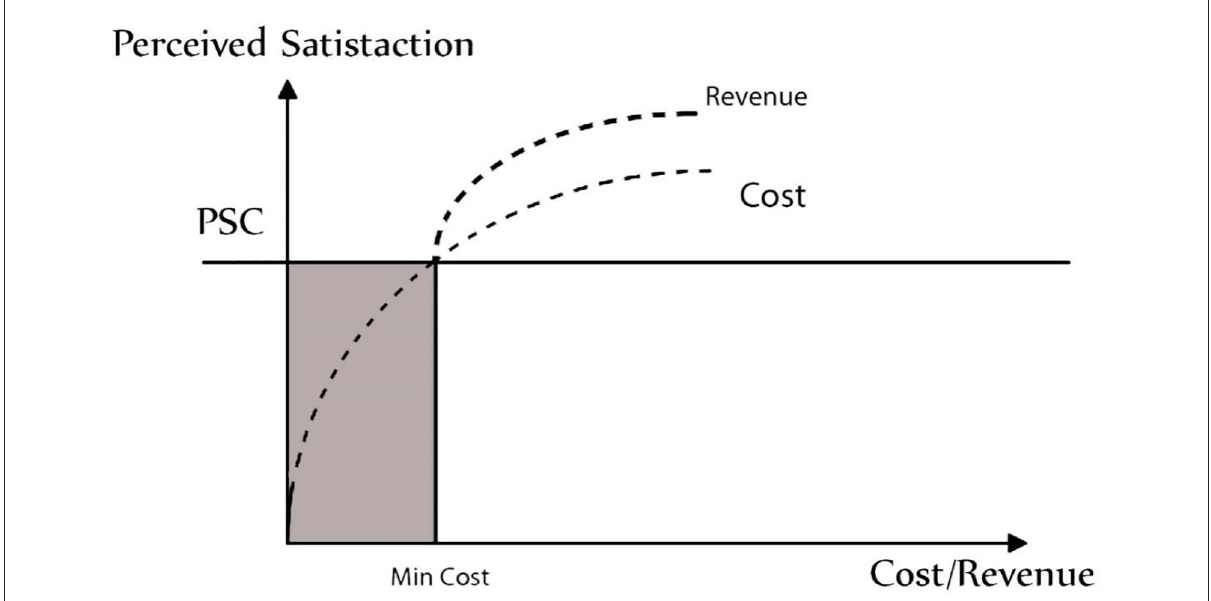
FIGURE7 Relationship between the levels of perceived satisfaction, costs, and